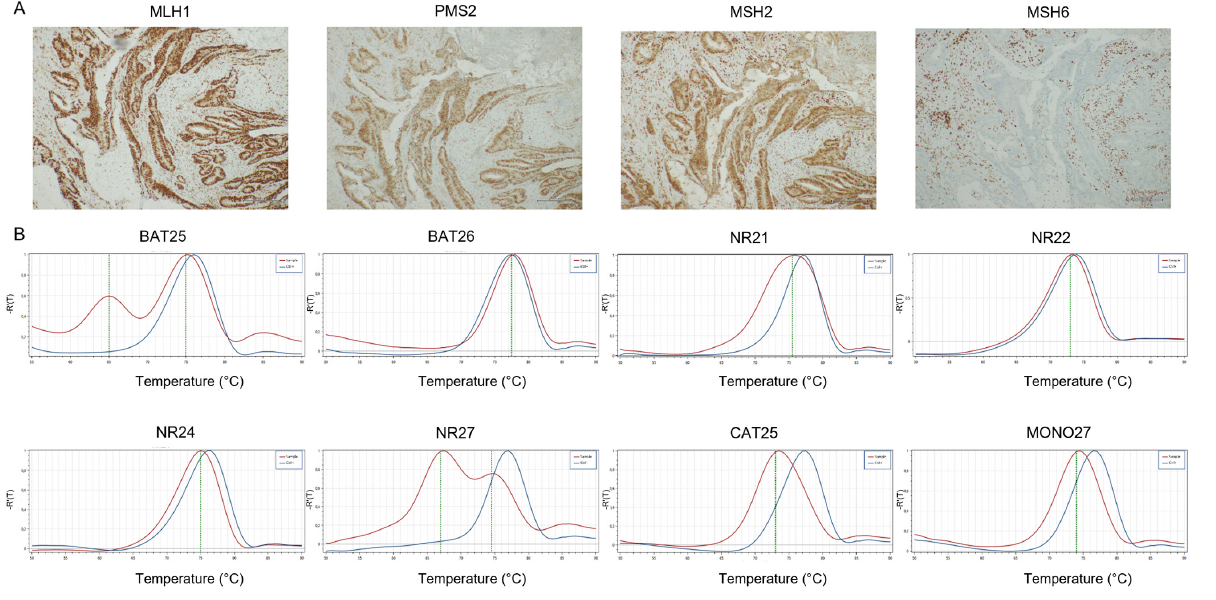
Figure 3. Representative results of CRC case showing loMMR-IHC and MSI-H by PCR. ( A ) MMR- IHC results: intact expression of MLH1, PMS2 and MSH2 in tumor cells (original magnification 10×); loss expression of MSH6 in tumor cells with positive internal control (original magnification 10×). ( B ) MSI-PCR results: stability of BAT26, NR22, NR24 and MONO27; instability of BAT25, NR21, NR27 and CAT25 (red lines indicate samples while blue lines indicate MSS controls).